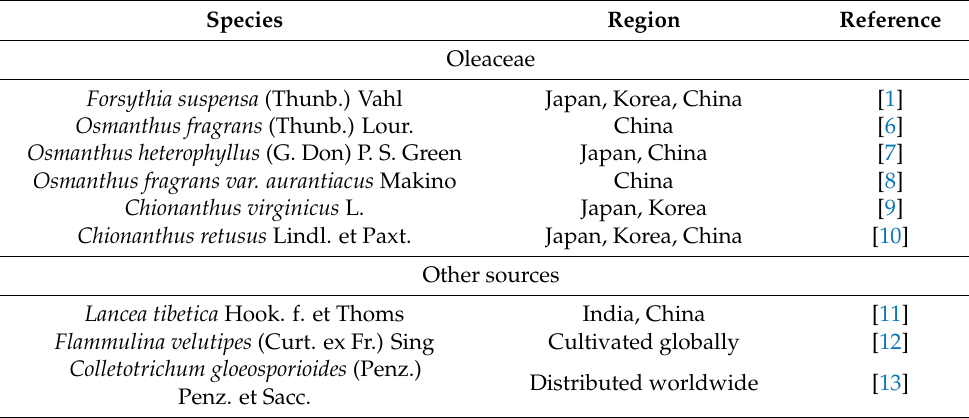
Table 1. Natural sources of phillyrin.